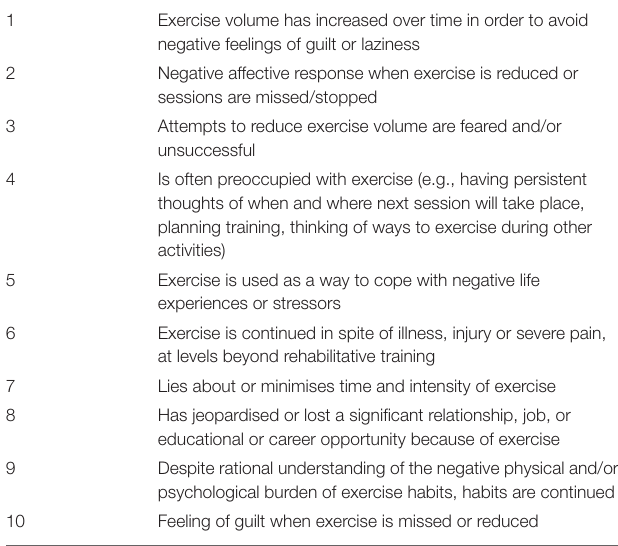
TABLE 1 | Criteria developed for rating the severity of exercise addiction based on symptoms that have been reported to occur in individuals who exercise excessively